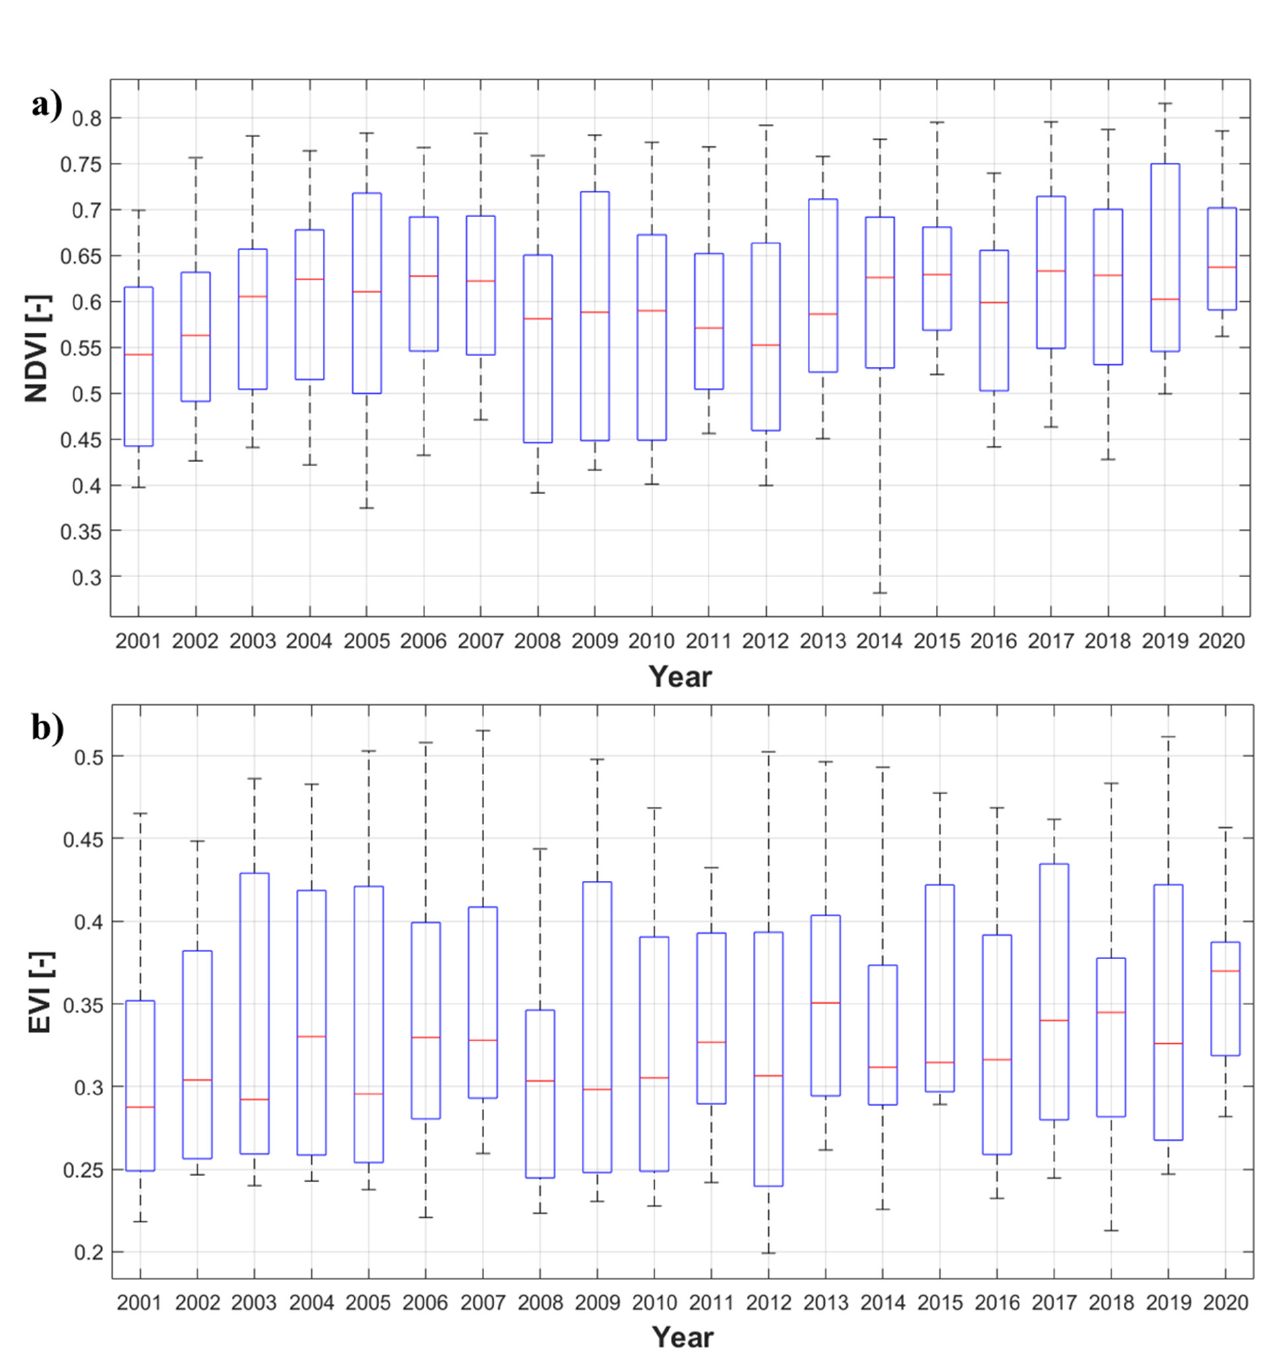
Figure 3. Boxplot for the inter-annual variability of ( a ) NDVI and ( b ) EVI over twenty years (2001–2020) for the UKR Basin.